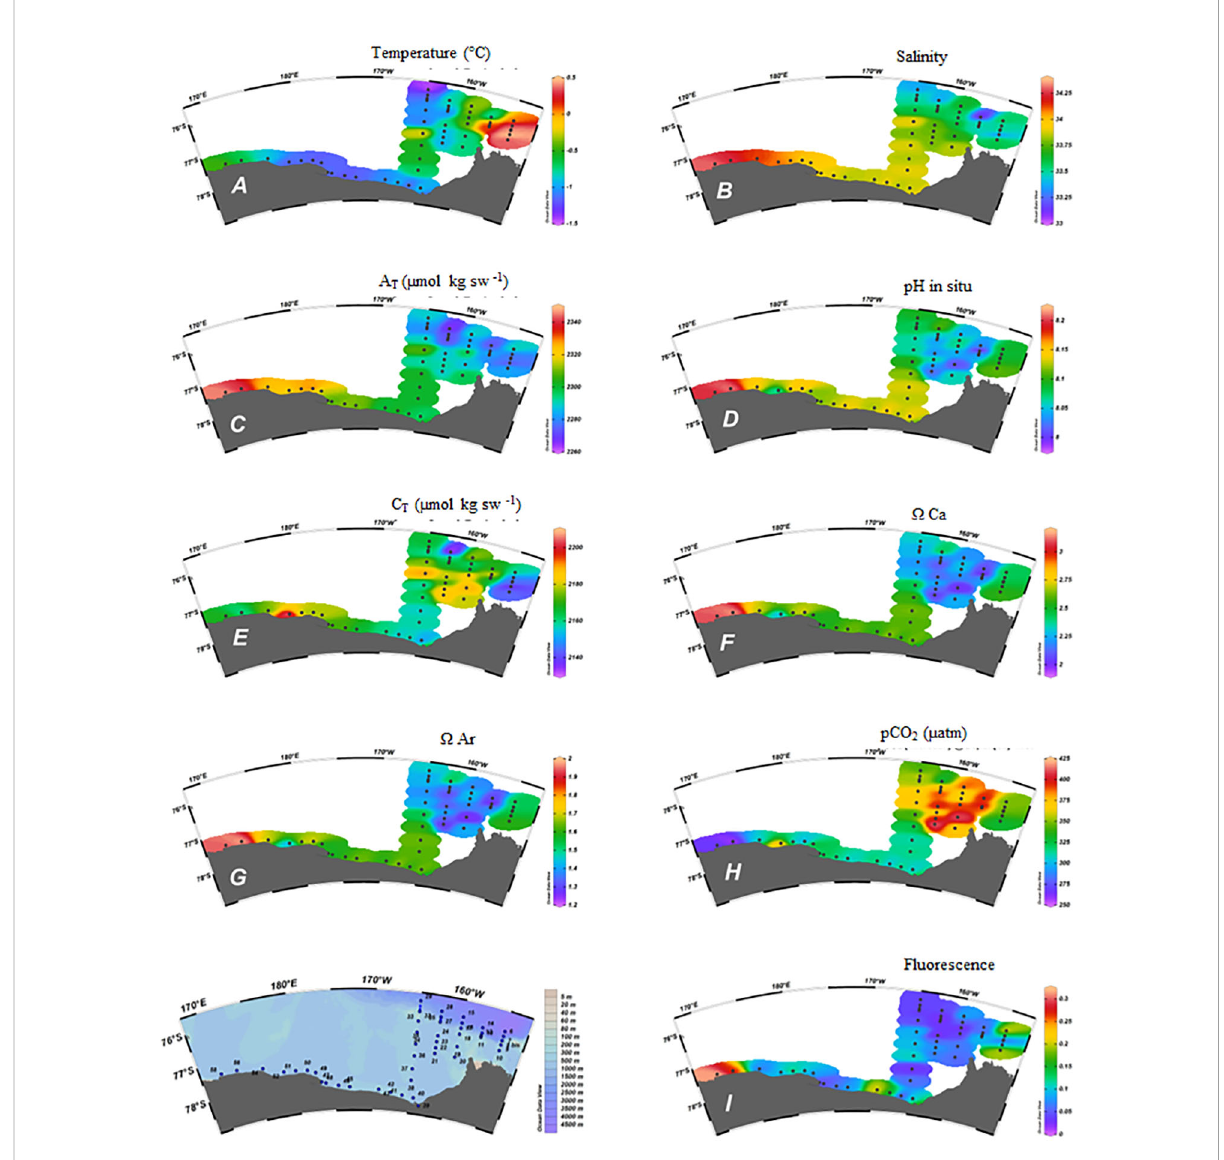
FIGURE 5 Spatial distribution in the surface samples of: (A) Temperature (°C); (B) Salinity; (C) A T (µmol kg sw -1 ); (D) pH in situ ; (E) C T (µmol kg sw -1 ); (F) W Ca; (G) W Ar; (H) pCO 2 (µatm); (I)